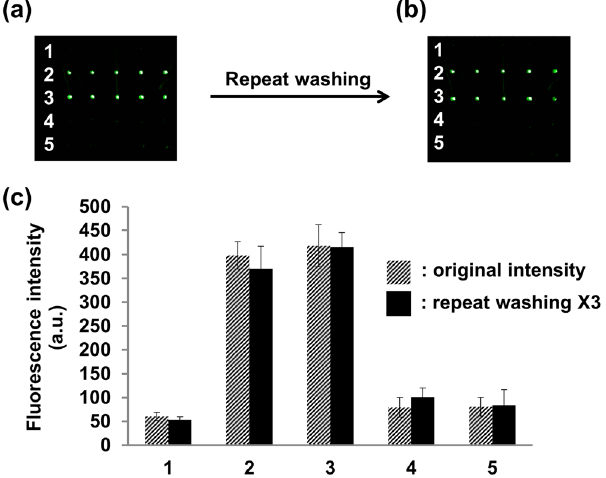
Figure 5. The fluorescence intensities of MBP (row 1), MBP F (row 2), a mixture of F tag -MBP F and MBP (row 3), F tag -MBP triton (row 4), and a mixture of F tag -MBP triton and MBP (row 5) ( a ) before and ( b ) after washing three times. ( c ) The quantified fluorescence intensities of ( a , b ).